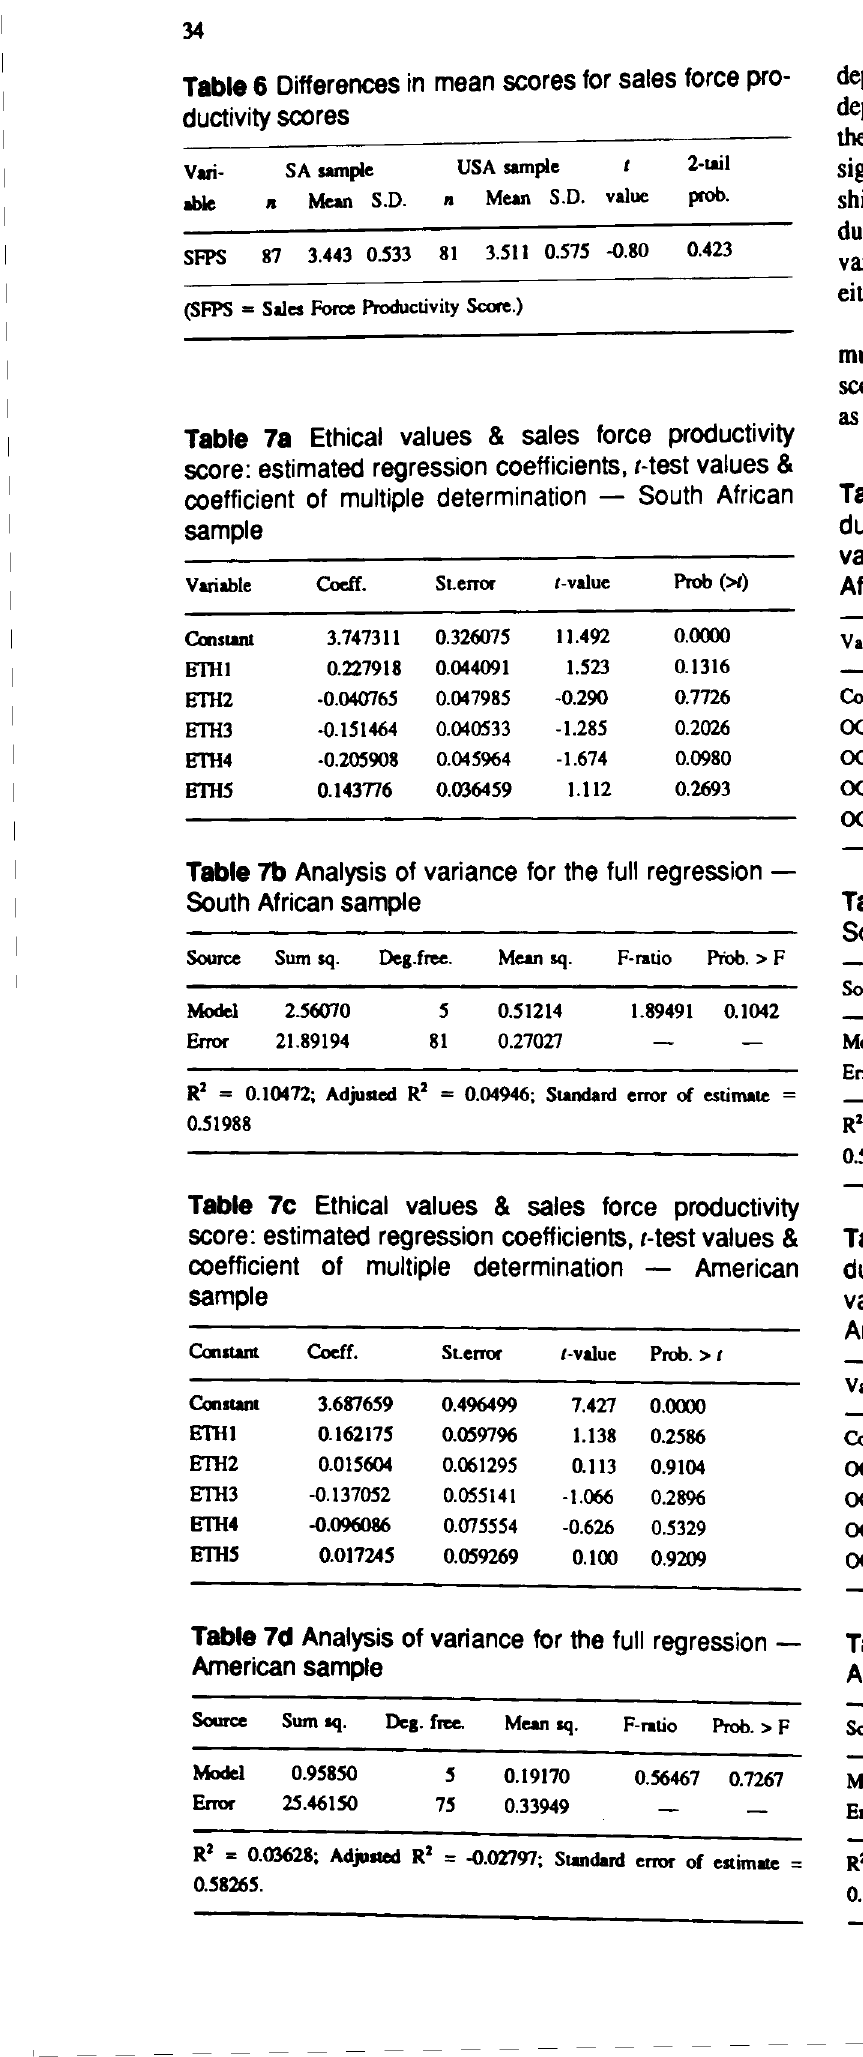
Table 6 Differences in mean scores for sales force pro